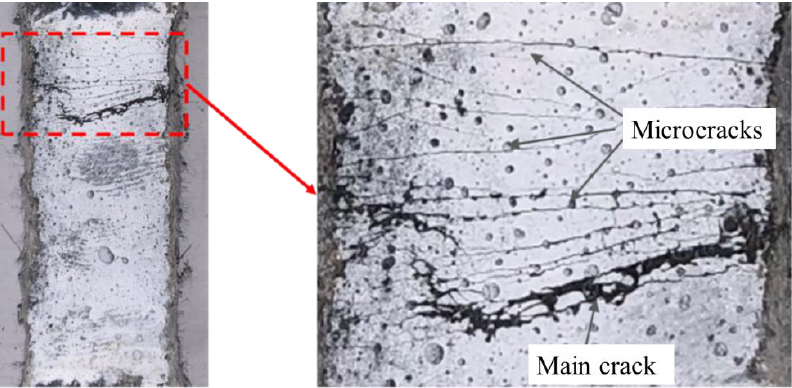
Figure 10 . Multi-crack pattern of the PF specimen. Figure 10. Multi-crack pattern of the PF specimen.